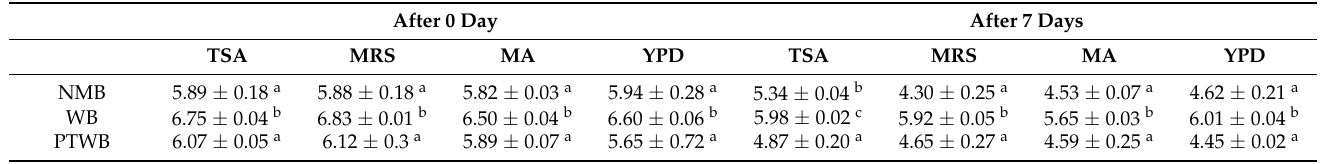
Table 3. The changes in the microbial population in salted Kimchi